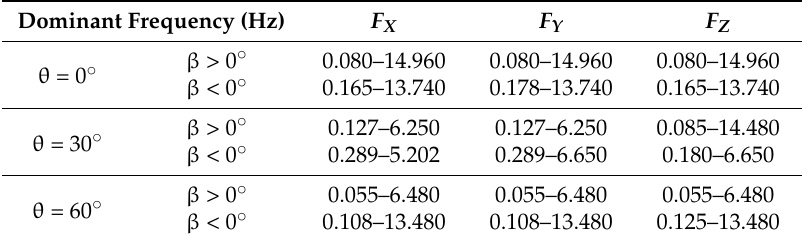
Table 2. Range of the dominant frequency of the total aerodynamic force acting on the wind rotor.